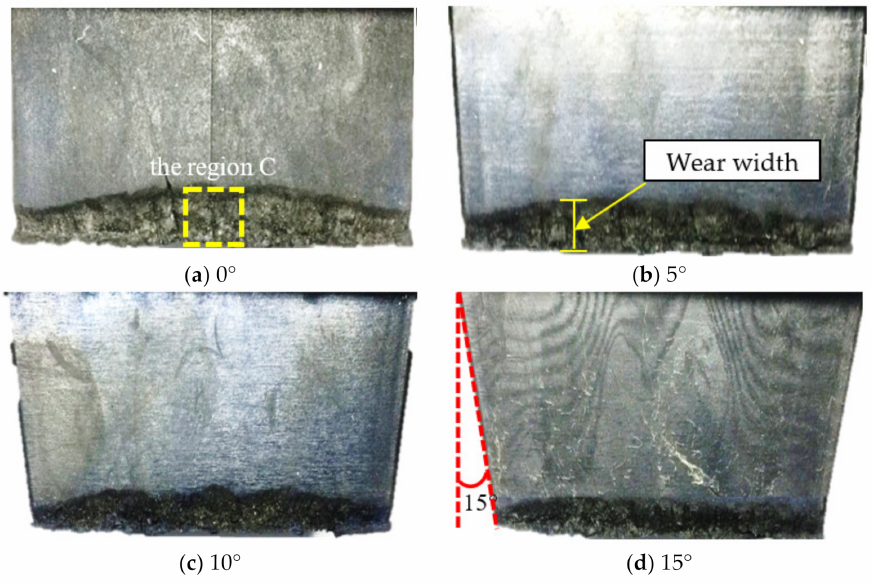
Figure 8. The changes in slide surface with draft angle.